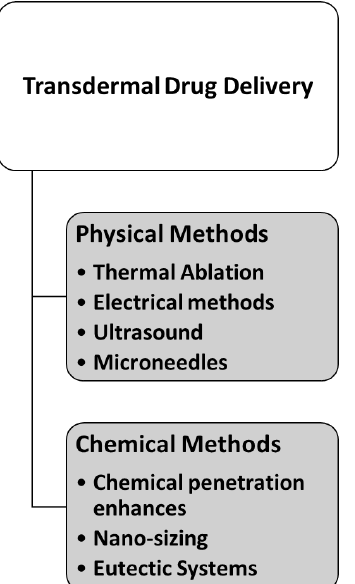
Figure 3. Approaches for enhancing drug transport across the skin.